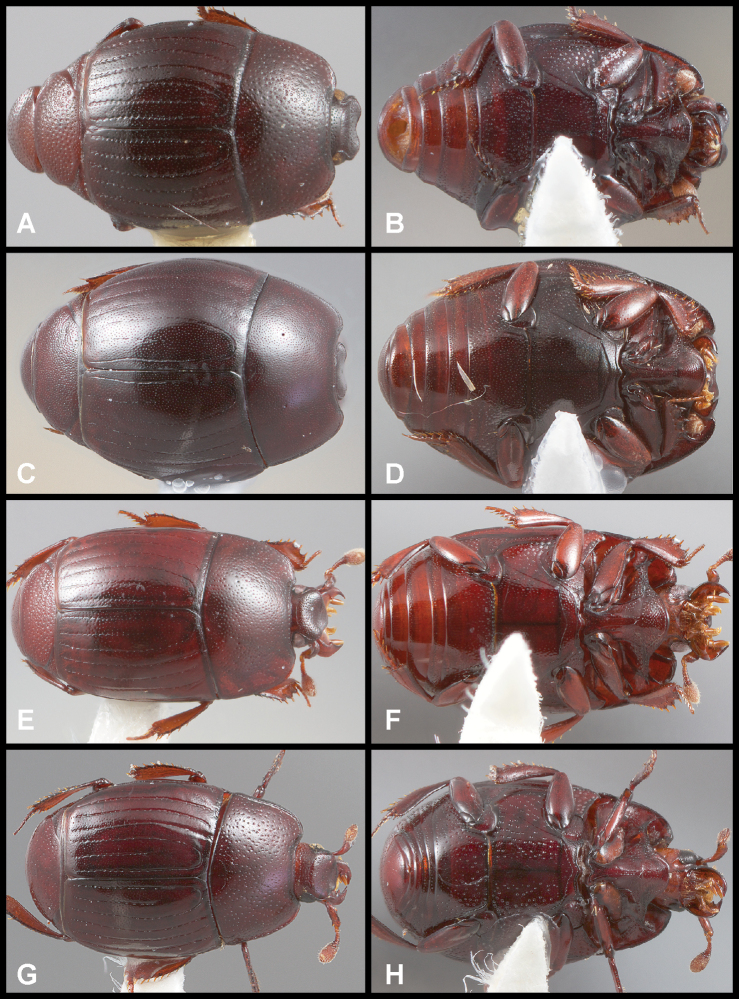
A, BPhelister
asperatus: A dorsal habitus B ventral habitus C, DP.
uniformis: C dorsal habitus D ventral habitus E, FP.
miscellus: E dorsal habitus F ventral habitus G, HP.
inbio: G dorsal habitus H ventral habitus.